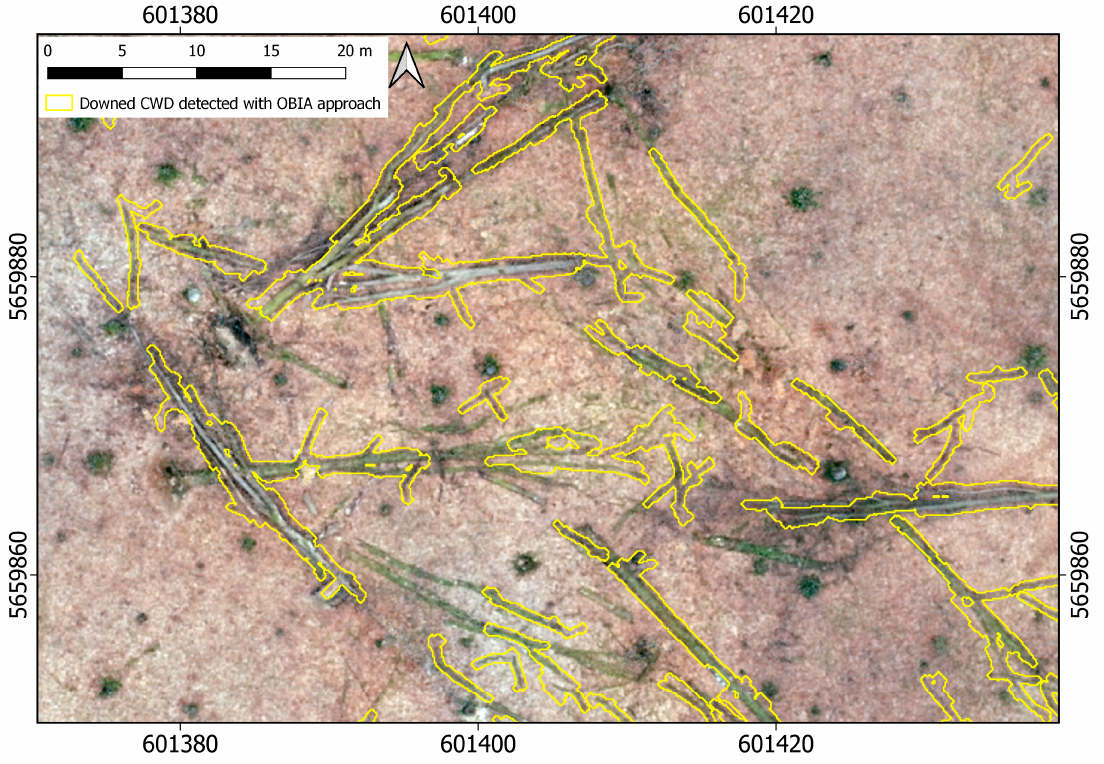
Figure 9. Subset of Figure 8 providing a detailed view of the mapped CWD. According to the map, the majority of the dead wood was detected, even though the object shapes do not match the dead wood boundaries precisely for all examples. Since the mapping method was designed to detect linear features, confusion between CWD and standing stems was avoided.